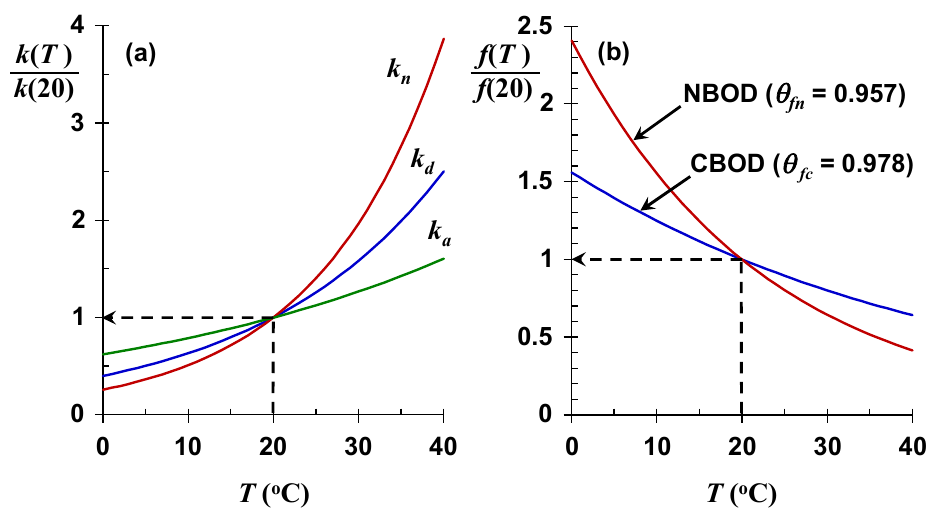
Figure 6. ( a ) Plot of the ratio of the Streeter–Phelps reaction rates normalized to the value at 20 °C versus temperature. The steepness of the slopes means that the rates connected with oxygen depletion ( k d and k n ) are more strongly impacted by temperature than the rate connected with oxygen replenishment ( k a ). ( b ) Plot of the ratio of the self-purification constants normalized to the value at 20 °C versus temperature. The monotonic declines mean that self-purification is reduced because reaeration increases at a slower rate than oxidation. Hence, the assimilation of oxygen-demanding pollutants due to self-purification will decrease as the planet’s natural surface waters warm. The curves also indicate that the decrease for NBOD will be greater than that for CBOD.